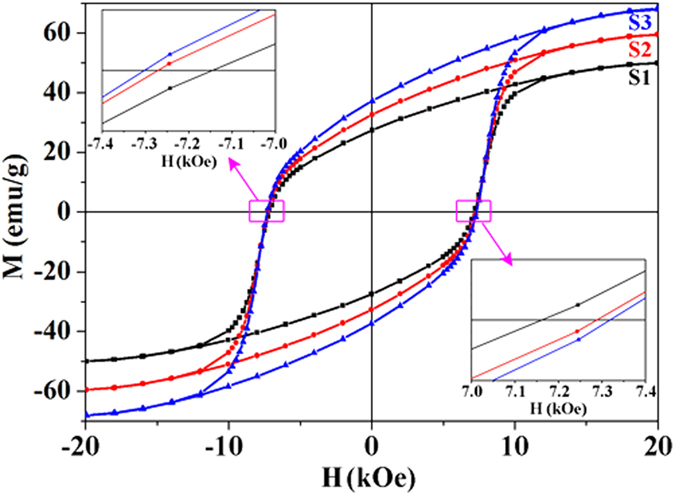
Representative RT magnetic hysteresis (M-H) loops of SrFe12O19 nanoribbons (S1–S3).